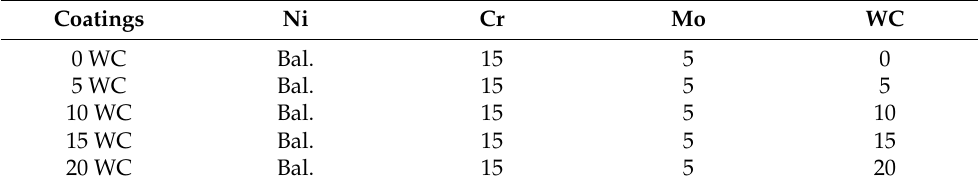
Table 2. Chemical composition of the powder (wt.%). Coatings Ni Cr Mo WC 0 WC Bal.